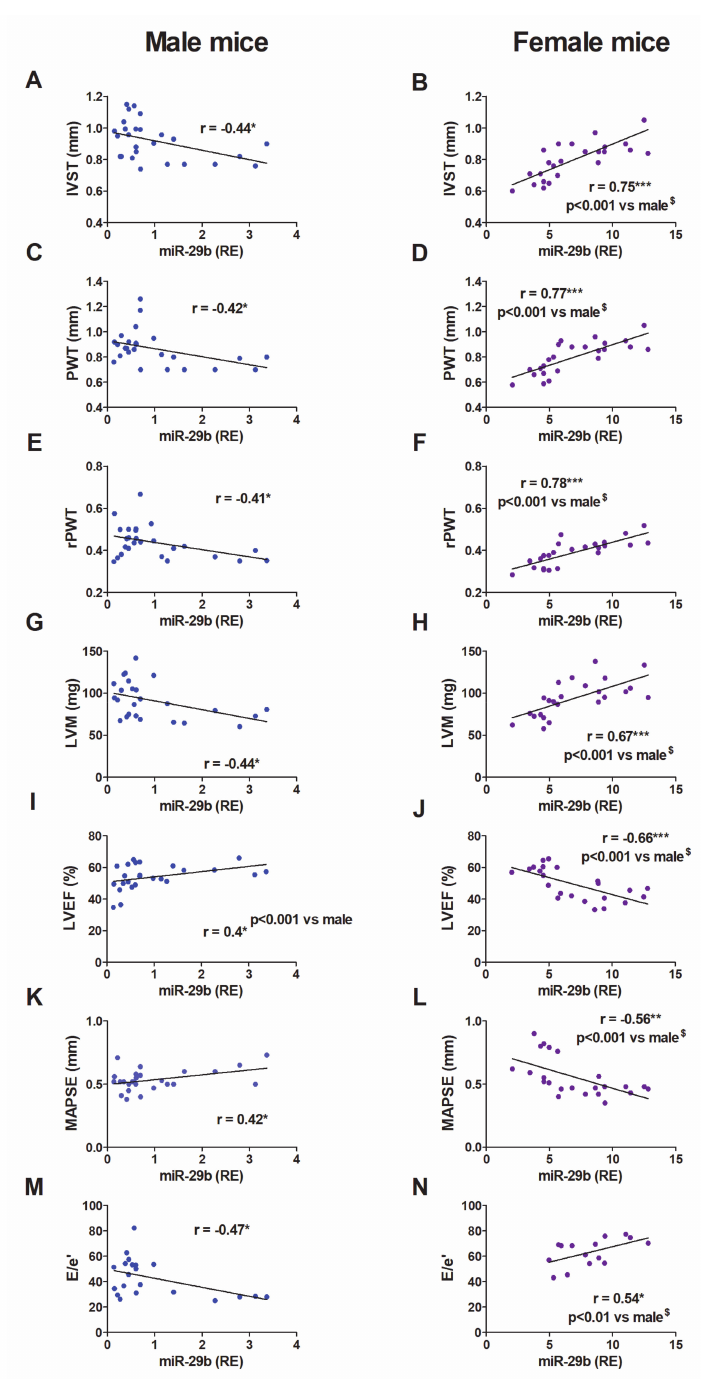
Figure 4. Relationship between LV miR-29b expression and morphological and functional echocardiographic parameters in mice. Linear regression and Pearson’s correlation analyses showing the relationship between LV miR-29b expression and morpho-functional echocardiographic parameters, in sham ( n = 8 males; n = 11 females) and TAC ( n = 17 males; n = 13 females) mice. IVS, interventricular septum ( A , B ); PWT, posterior wall thickness ( C , D ); rPWT, relative posterior wall thickness ( E , F ); LVM, LV mass ( G , H ); LVEF, LV ejection fraction ( I , J ); MAPSE, mitral annular plane systolic excursion ( K , L ); E / e (cid:48) , the ratio of peak early transmitral flow velocity (E) to peak early myocardial tissue 1 velocity (e (cid:48) ) ( M , N ), r, Pearson’s correlation coe ffi cient. * p < 0.05, ** p < 0.01, *** p < 0.001. $ Comparative analysis of female vs. male correlations with